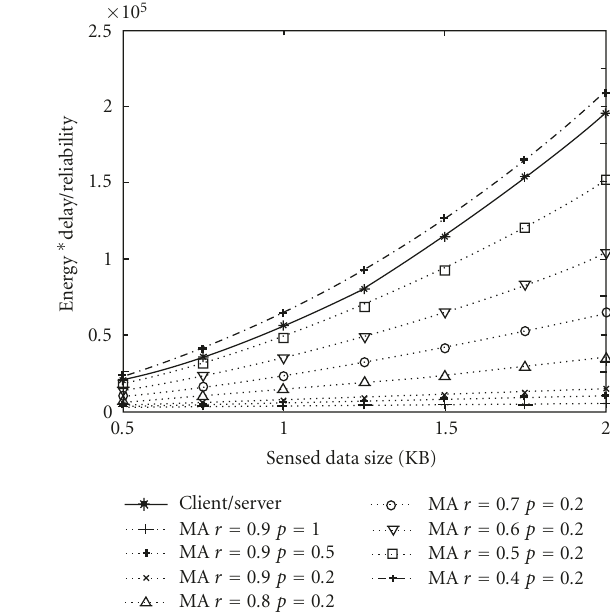
Figure 13: The impact of S data , r , and ρ on e .